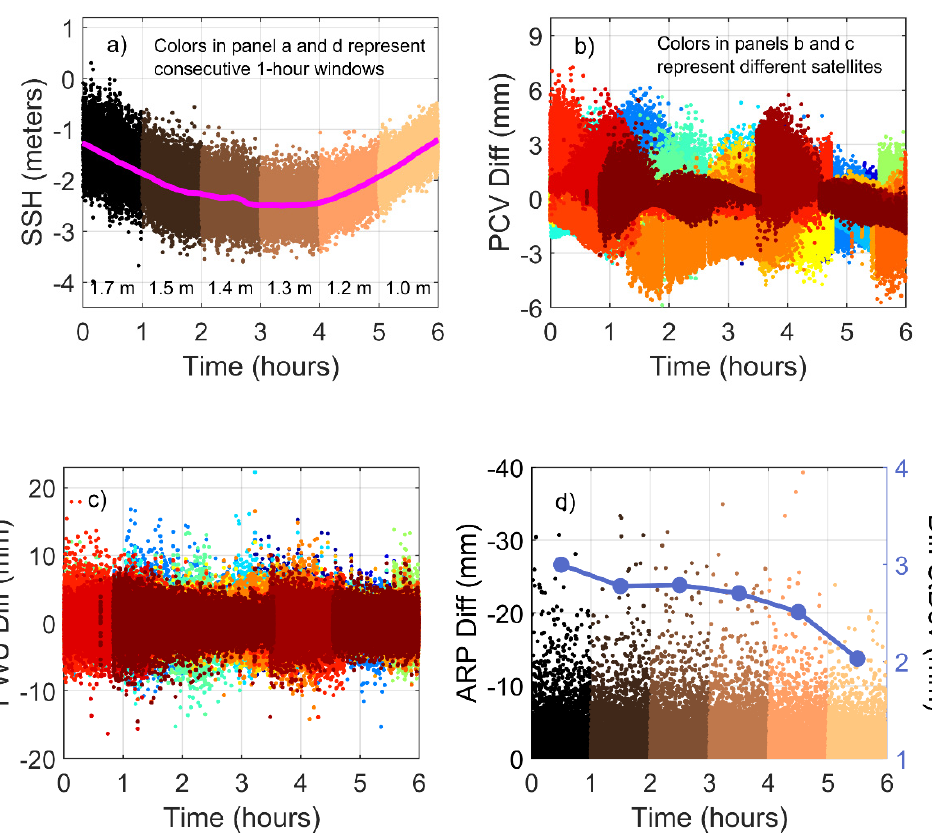
Figure 7. GPS / INS solution and orientational variation from a selected session window; ( a ) SSH showing decreasing sea state over consecutive 1-h sessions colored accordingly. Dots show the raw SSH, the solid magenta line shows the smoothed SSH with a 25-min moving mean; the number annotated at the bottom of ( a ) indicates the SWH computed over corresponding 1-h window; ( b ) di ff erence between adaptive PCV and static PCV for all satellites (colored accordingly) involved within the same time window, taken as adaptive minus static; ( c ) di ff erence between dynamic PWU and static PWU for all satellites involved within the same time window, taken as dynamic minus static; ( d ) Di ff erence between orientation compensated ARP and static ARP for the same time window, taken as orientation compensated minus static; blue line shows the standard deviation (StDev) of the di ff